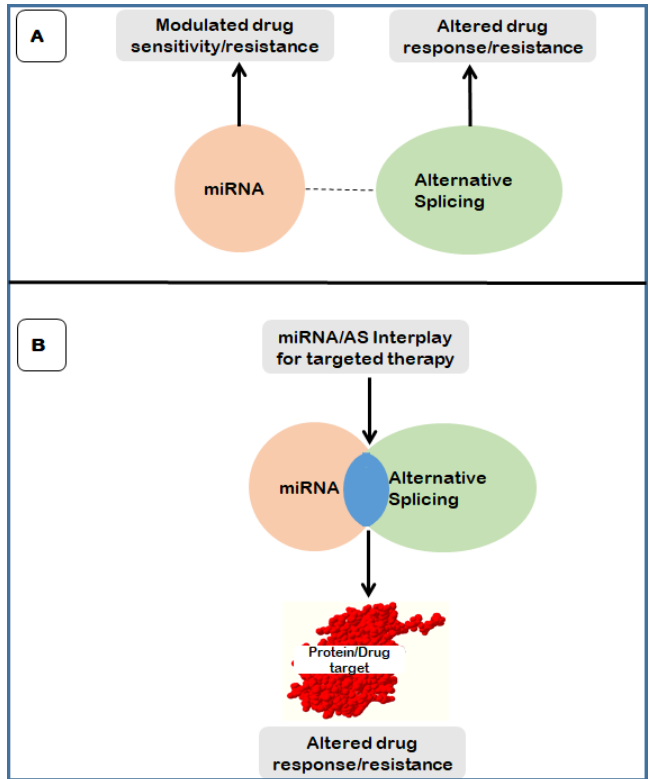
Figure 3. The potent miRNA/AS interplay target in anti-cancer drug resistance. Adequate research data is available on the individual roles of miRNA and AS in anti-cancer drug resistance ( A ). However, the research gap lies significantly in the interaction of these two strictly regulated processes ( B ), which holds potent therapeutic targets.